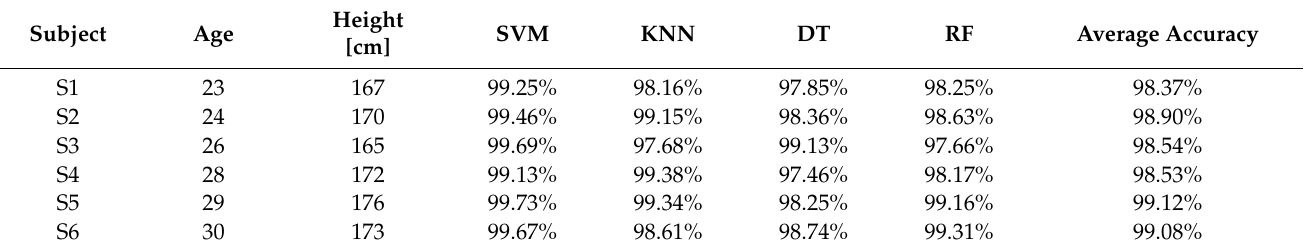
Table 4. The accuracy of motion pattern recognition of different subjects under five-fold cross-validation.